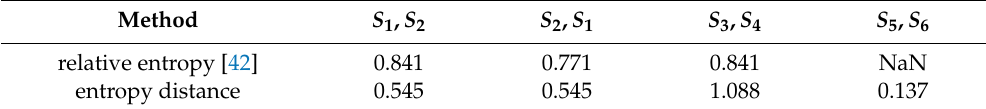
Table 4. The comparison results of two distance methods. Method S 1 , S 2 relative entropy [42] 0.841 entropy